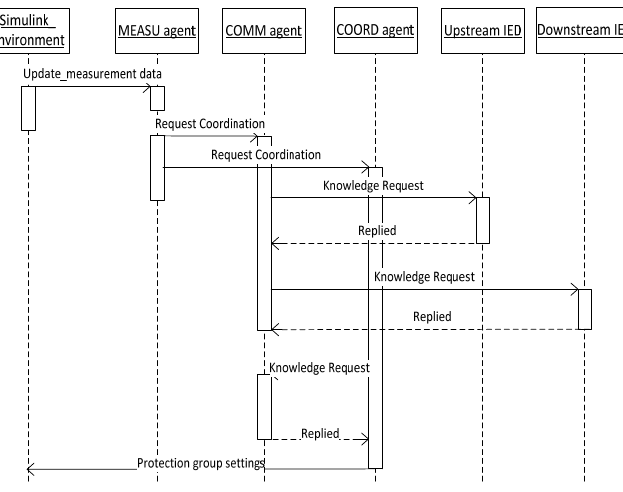
Figure 7. UML Sequence diagram for agent interaction to update protection settings within MAPS.